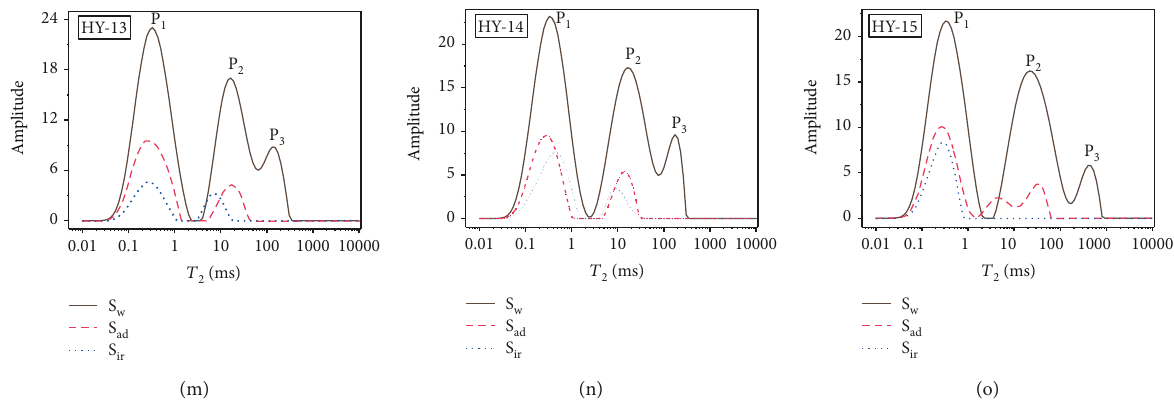
Figure 4: NMR T 2 distribution before microwave treatment with various water